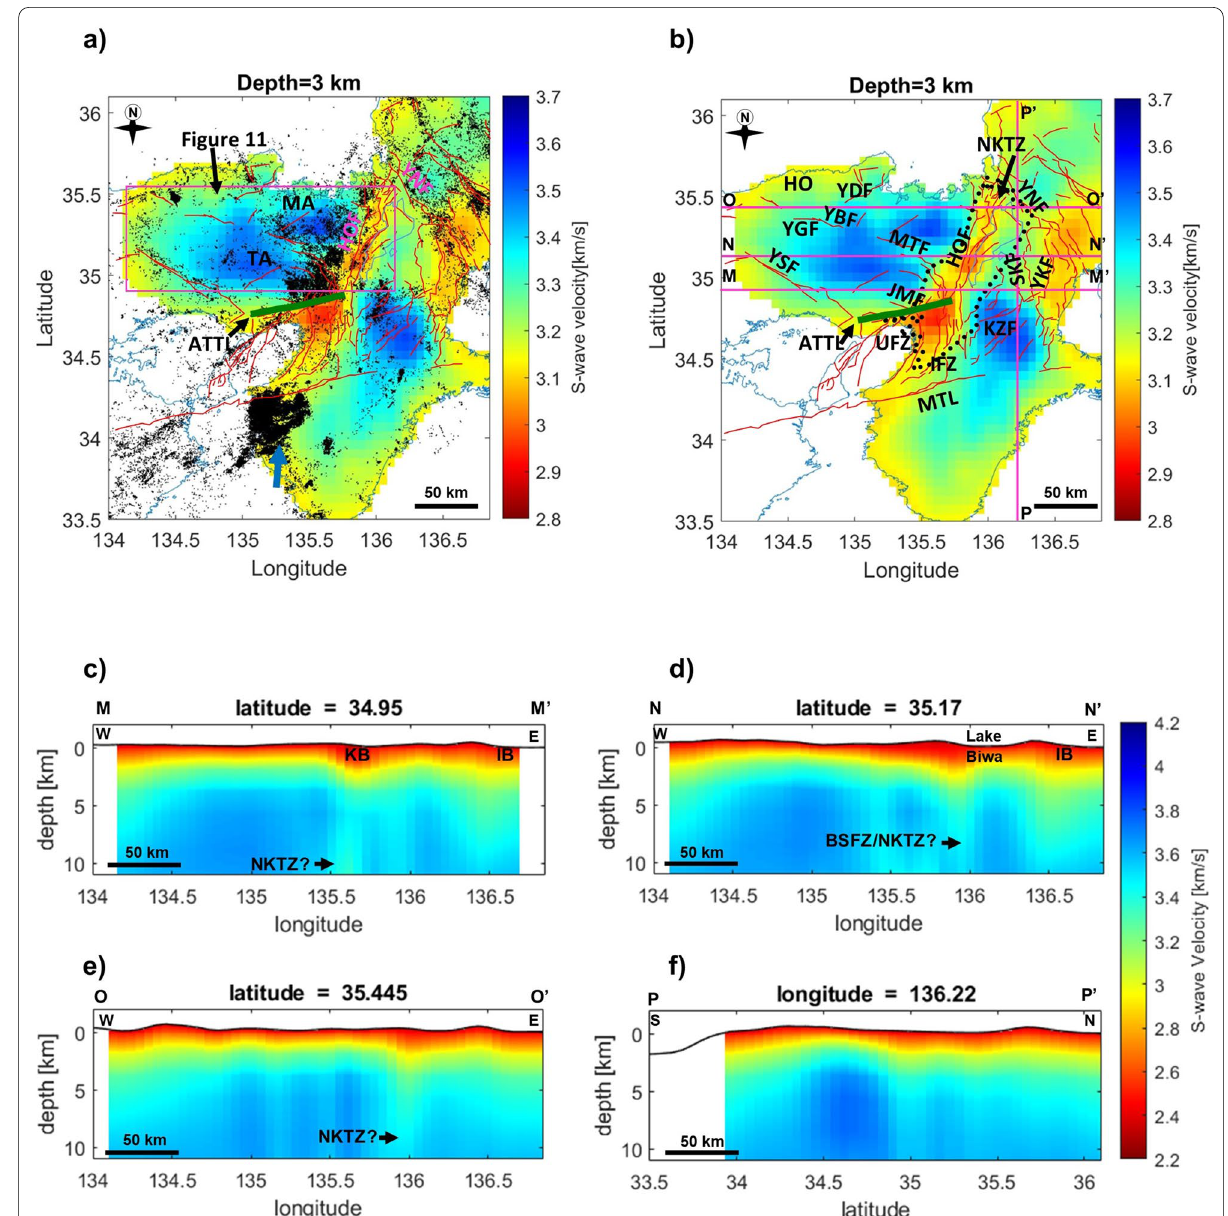
Fig. 10 a Map of seismic events that occurred during the January 2001 to December 2012 period (Yano et al. 2017) superimposed on the S-wave velocity model horizontal slice at 3 km depth below sea level. Plotted hypocenters (black dots) are for earthquakes ranging from 0 to 6.5 in moment magnitude for depths shallower than 12 km. Blue arrow indicates the location of dense distribution of earthquake hypocenters along the western part of the Kii Mountainland. b Distribution of active faults superimposed on the S-wave velocity model horizontal slice at 3 km depth below sea level. Solid red lines represent active faults documented before this study (Research Group for Active Faults of Japan 1991). Thick dashed black closed-curve and a solid green line indicate the locations of the Niigata–Kobe Tectonic Zone (NKTZ) and the Arima-Takatsuki Tectonic Line (ATTL), respectively. Also shown are the locations of the Median Tectonic Line (MTL), Yamada Fault (YDF), Yamasaki Fault (YSF), Jumantsuji Fault (JMF, a member of the ATTL), Yabu Fault (YBF), Yagi Fault (YGF), Mitoke Fault (MTF), Hanaori Fault (HOF), Kizugawa Fault (KZF), Suzuka Fault (SKF), Yokkaichi Fault (YKF), Yanagase Fault (YNF), Uemachi Fault Zone (UFZ), Ikoma Fault Zone (IFZ), Tanba Block (TA), Hokutan Block (HO), and the Maizuru Block (MA). c – f Vertical sections showing the S-wave velocity variation beneath the profiles marked as solid magenta lines in b . Inferred locations of the Kyoto basin (KB), Ise basin (IB), Lake Biwa and the Biwako-seigan Fault Zone (BSFZ) and/or Niigata–Kobe Tectonic Line (NKTZ) along the profile are also shown on the vertical